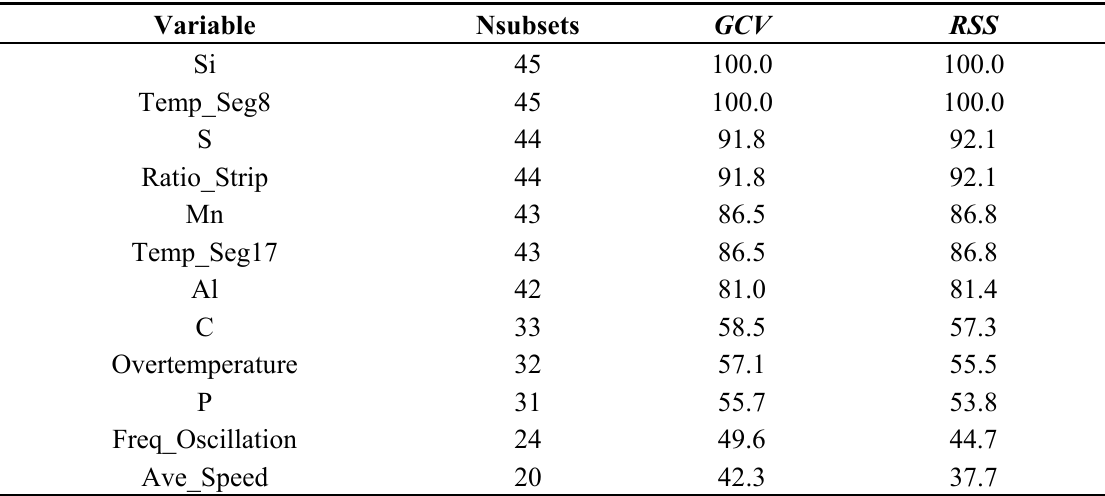
Table 3. Evaluation of the importance of the variables that form the model for the C factor according to criteria Nsubsets, GCV and RSS .